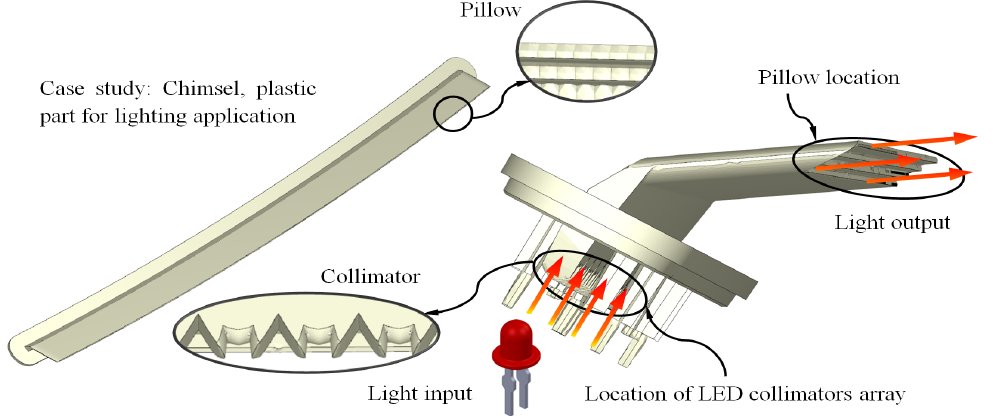
Figure 1. Description of the plastic part for lighting application case study.